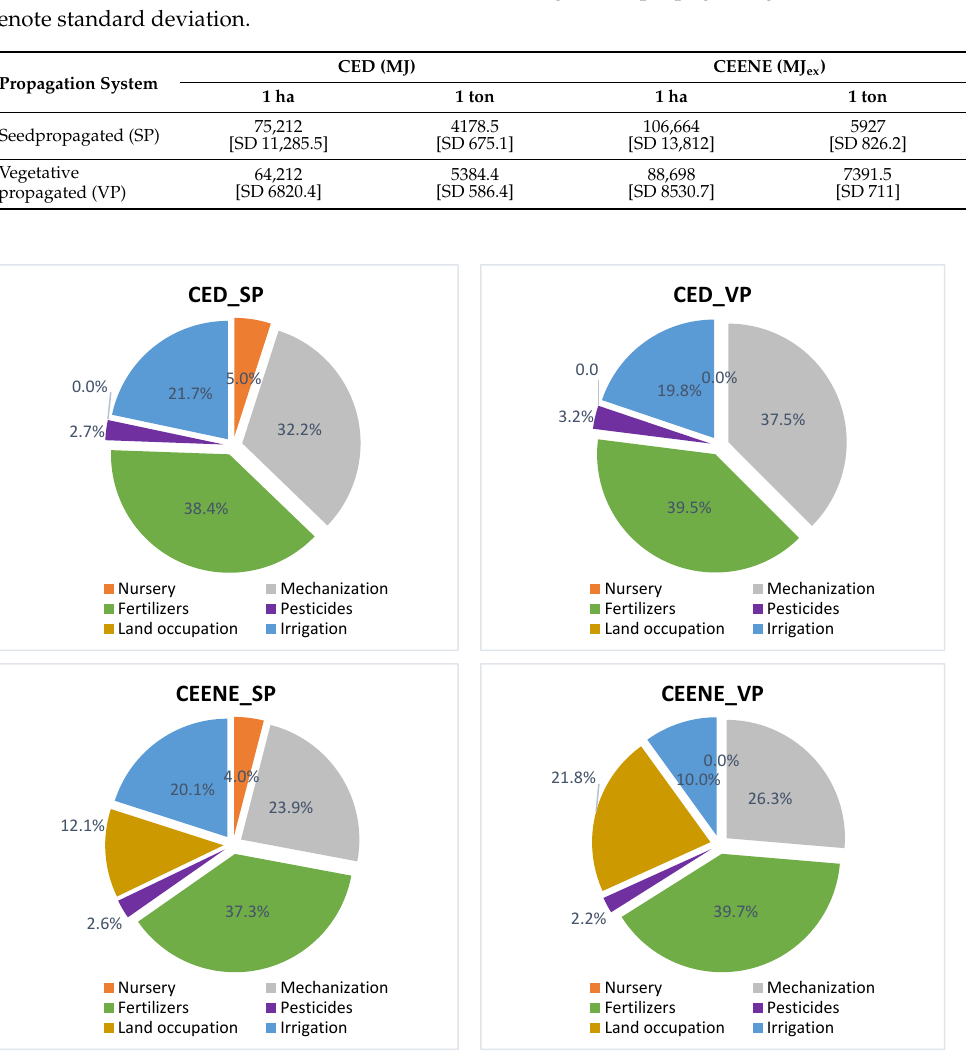
Figure 2. The process contribution to total CED and CEENE impacts for seed propagated (SP) and vegetative propagated (VP) globe artichoke.